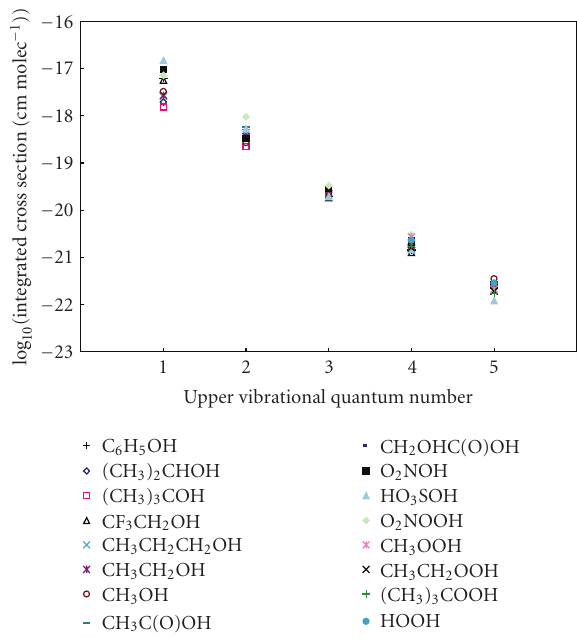
Figure 1: Compilation of experimental integrated cross-sections of O–H stretching